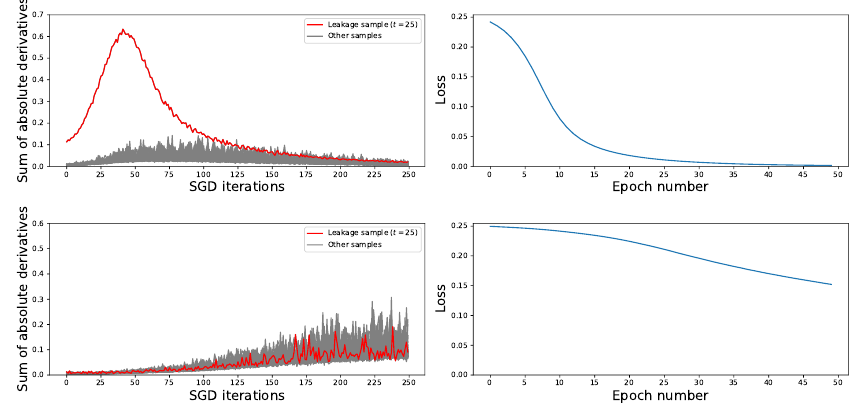
Figure 3: Sum of absolute derivatives and loss over SGD iterations. Top Left: sum of absolute derivatives for good key. Top right: loss for good key. Bottom left: sum of absolute derivatives for bad key. Bottom right: loss for bad key